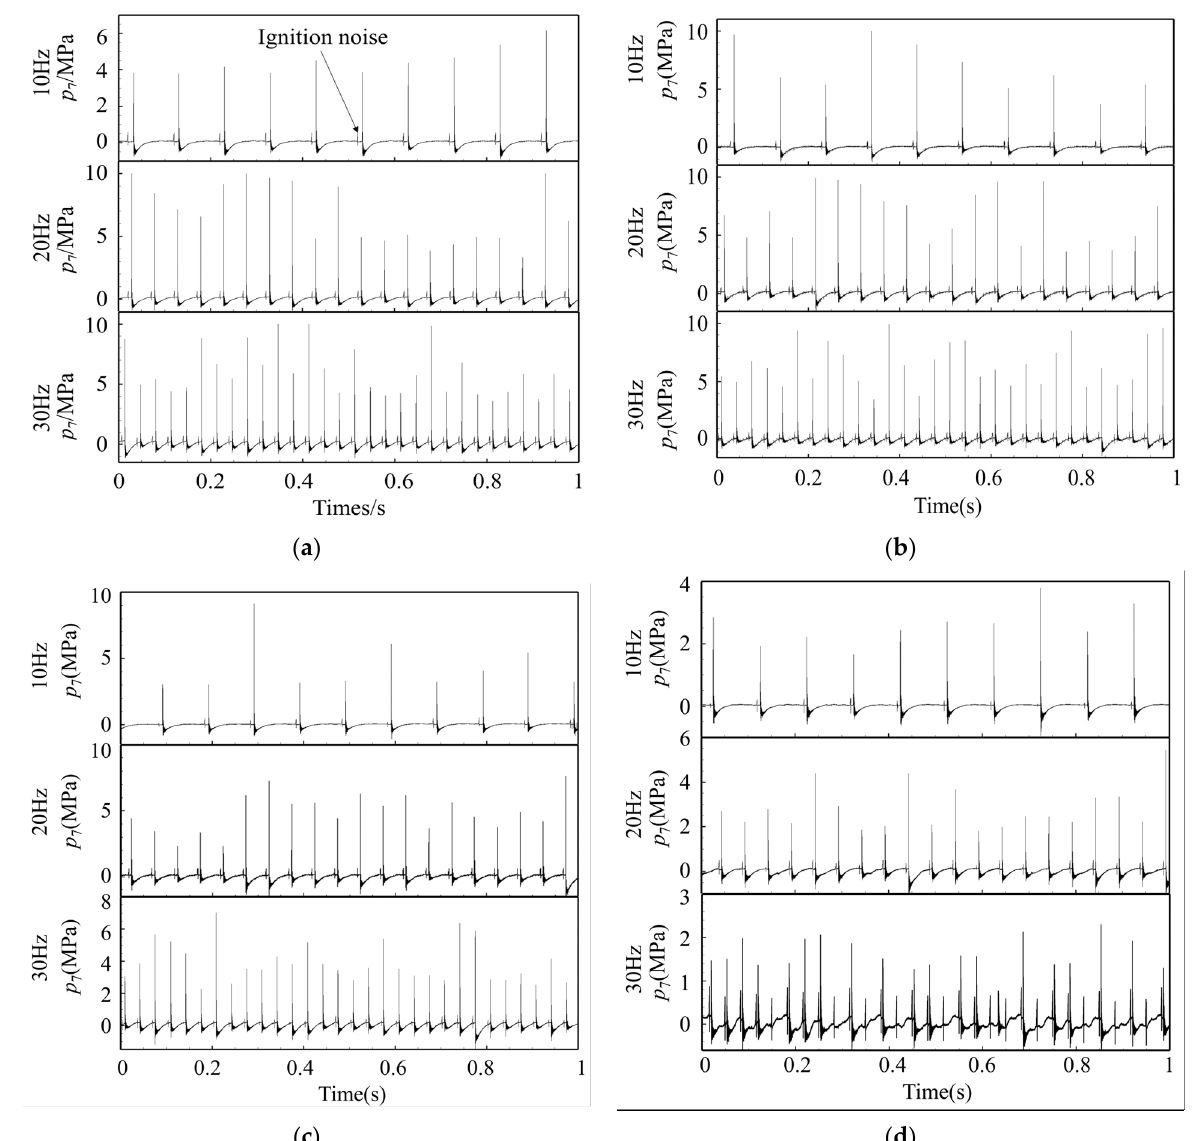
Figure 2. Pressure history at different working conditions. ( a ) Pressure profiles at 10–30 Hz when T t = 288 K. ( b ) Pressure profiles at 10–30 Hz when T t = 323 K. ( c ) Pressure profiles at 10–30 Hz when T t = 423 K. ( d ) Pressure profiles at 10–30 Hz when T t = 523 K.